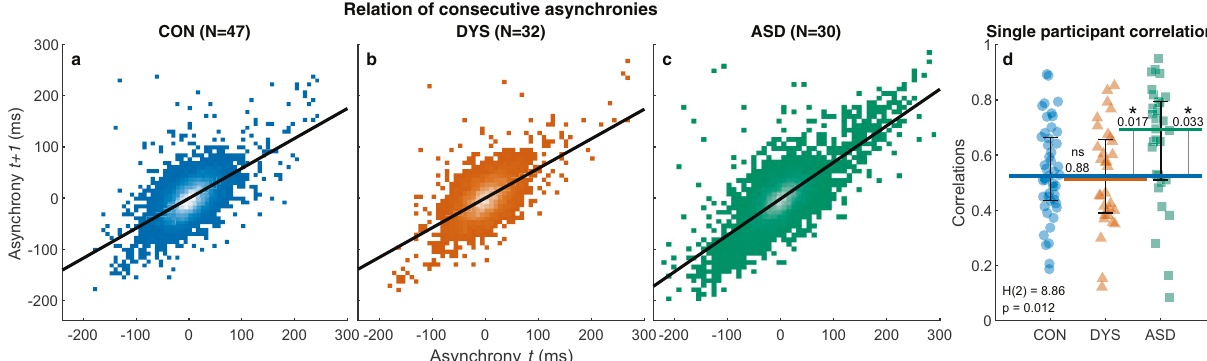
Fig. 2 Correlation between consecutive asynchronies (errors) is highest in the ASD group revealing reduced online error correction. a – c Scatter plots showing correlations between consecutive asynchronies: a neurotypical (CON, control), b dyslexia (DYS), and c ASD. Individual asynchronies were plotted with respect to each participant ’ s mean asynchrony, yielding a mean of 0 ms. Consecutive asynchronies are positively correlated in all groups. This positive correlation is largest in the ASD group, re fl ecting reduced online error correction. Luminance scale is equal in ( a – c ): white, the maximum number of asynchronies in a bin, is 165 in all graphs. d Single participant correlations also show the impairment in error correction for the ASD group compared with the neurotypical and dyslexia groups. The median of each group is denoted as a line of the same color; error bars around this median denote an interquartile range. Kruskal – Wallis H -statistic and the corresponding p value are plotted in the bottom-left corner; p values of comparisons between groups are plotted next to the line connecting the groups ’ medians. N = 109 subjects ( N CON = 47, N DYS = 32, N ASD = 30). Source data are provided as a Source Data fi